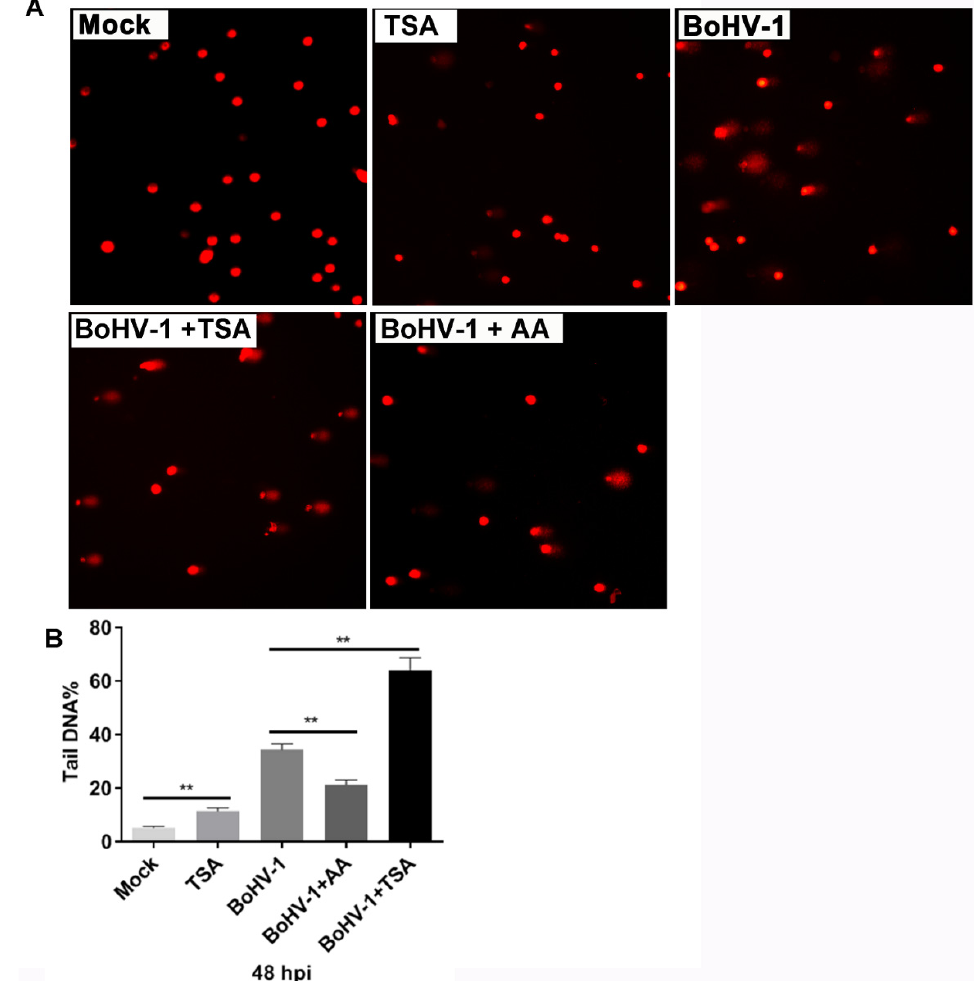
Figure 4. The effects of HDAC inhibitor TSA had on BoHV-1 infection-induced DNA damage in A549 cells. ( A ) A549 cells were infected with BoHV-1 (MOI = 0.1) and treated with either AA or TSA at indicated concentrations, plus a pretreatment for 2 h with indicated inhibitors, respectively. After infection for 48 h, DNA damage in individual cells was determined by using comet assay, the images were acquired under a fluorescence microscope. ( B ) three hundred cells were randomly selected from each sample for the analysis of TailDNA% with software CASP. Data shown are means ± SD of three independent experiments. Statistical analyses were performed using Student’s t -test (** p <